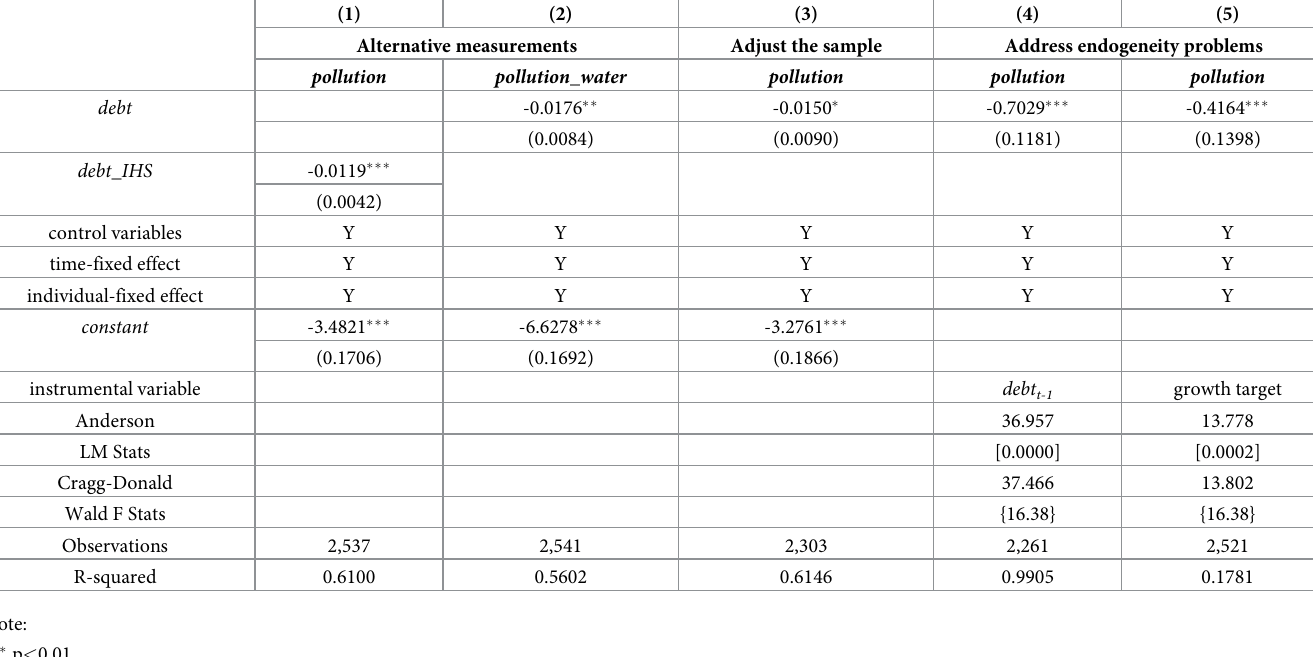
Table 5. Robustness